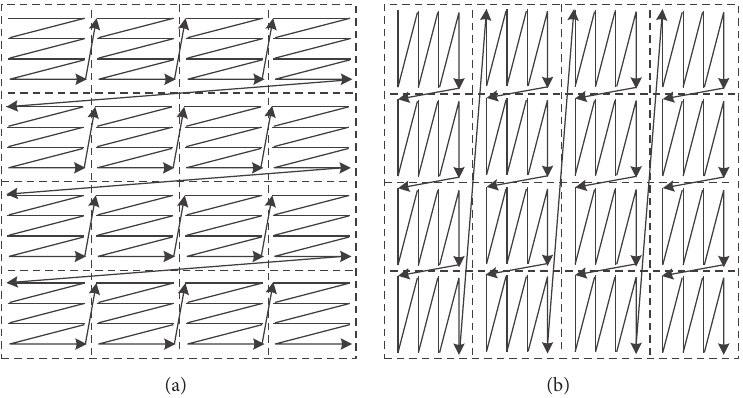
Figure 3: Scanning order for 16 × 16 macroblock. (a) Horizontal z scan [3]. (b) Vertical z scan.